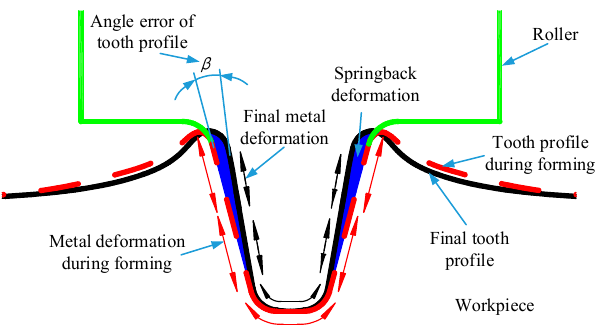
Figure 6. Schematic of profile error generation.